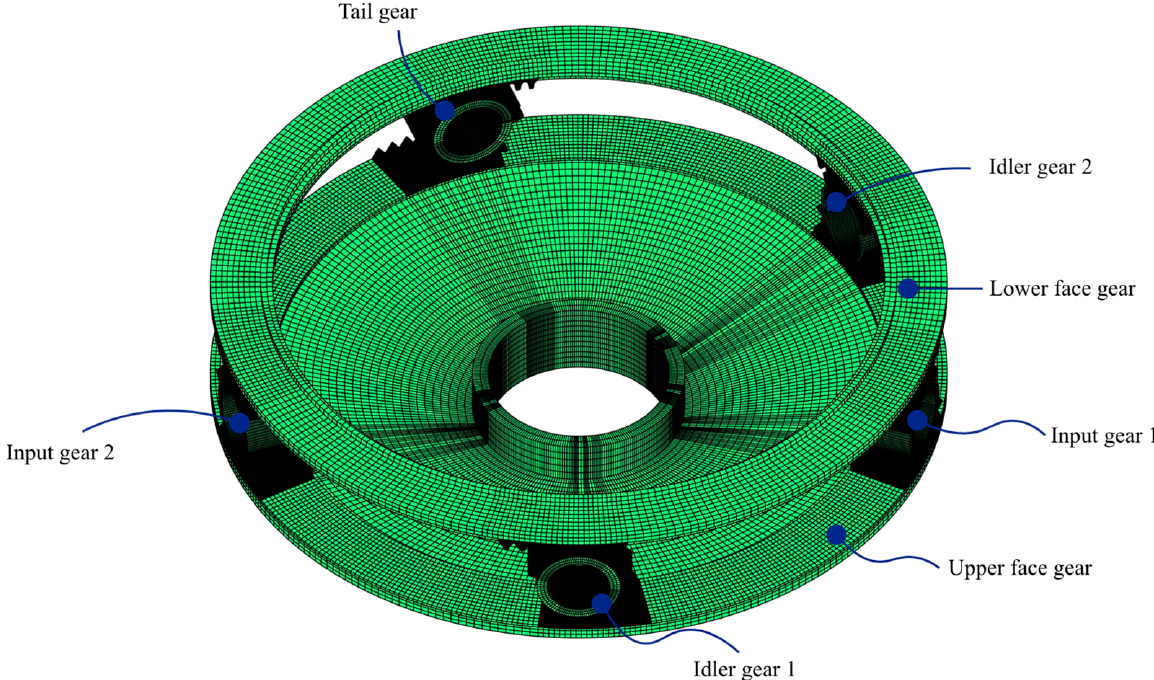
Figure 6. Schematic diagram of the finite element model of the transmission system.